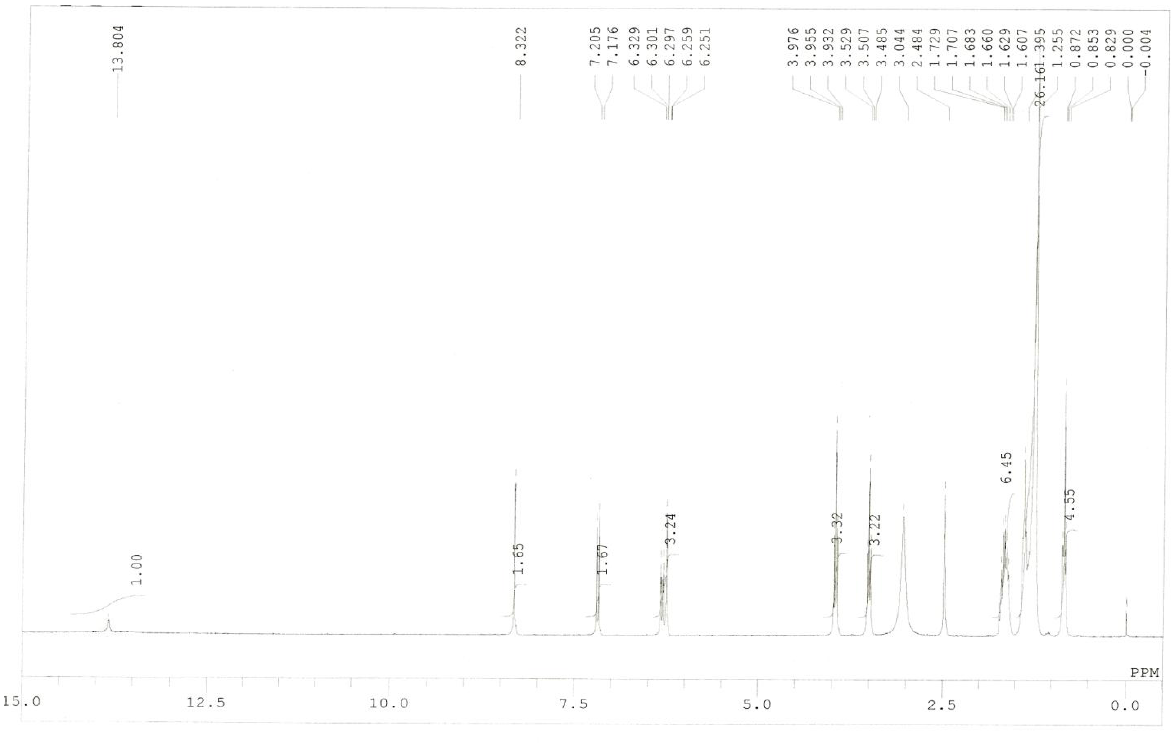
Fig. S1 – 1 H NMR Spectrum of ligand, H